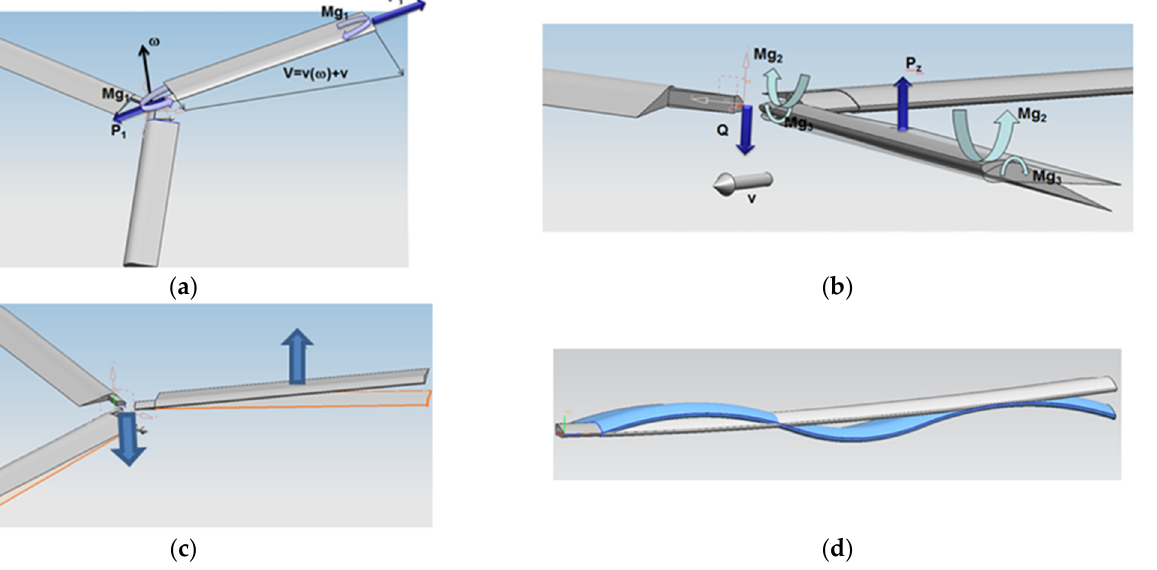
Figure 3. Diagram of loads on helicopter rotor blades: ( a ) Tensile force—centrifugal P 1 , moment bending the blade in the direction of flow M g1 ; ( b ) Lift force P z , bending moment related to the induced drag—M g2 ; aerodynamic moment M g3 ; ( c ) Loads related to the change in position of the blades during flight; ( d ) One vibration mode.